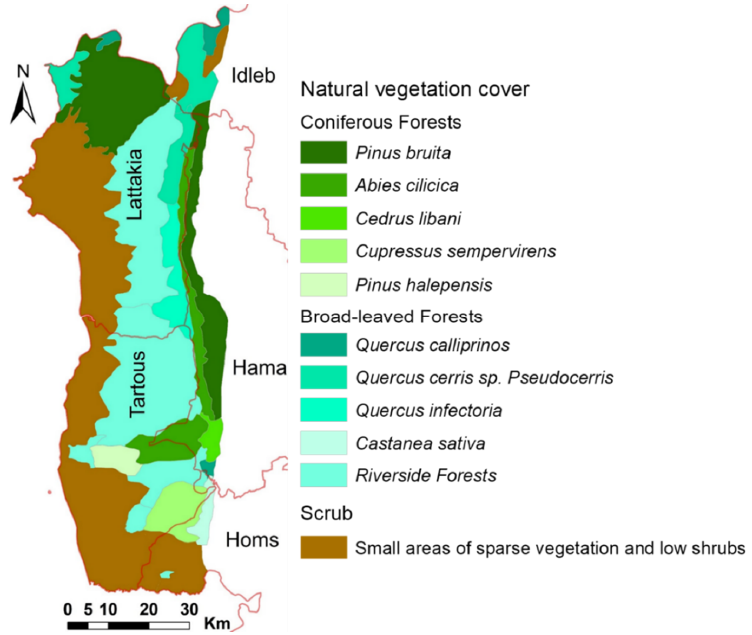
Figure 4. Natural vegetation cover in the Syrian coast region for 2010 adapted from [57–60].